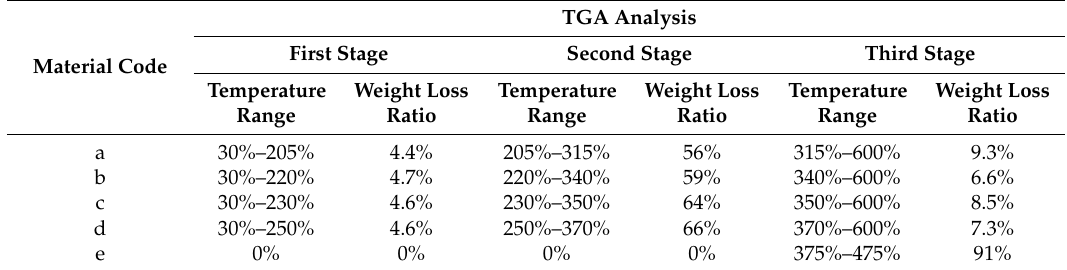
Table 9. Comparison of the pyrolysis characteristics of the unmodified and modified wood fibers.